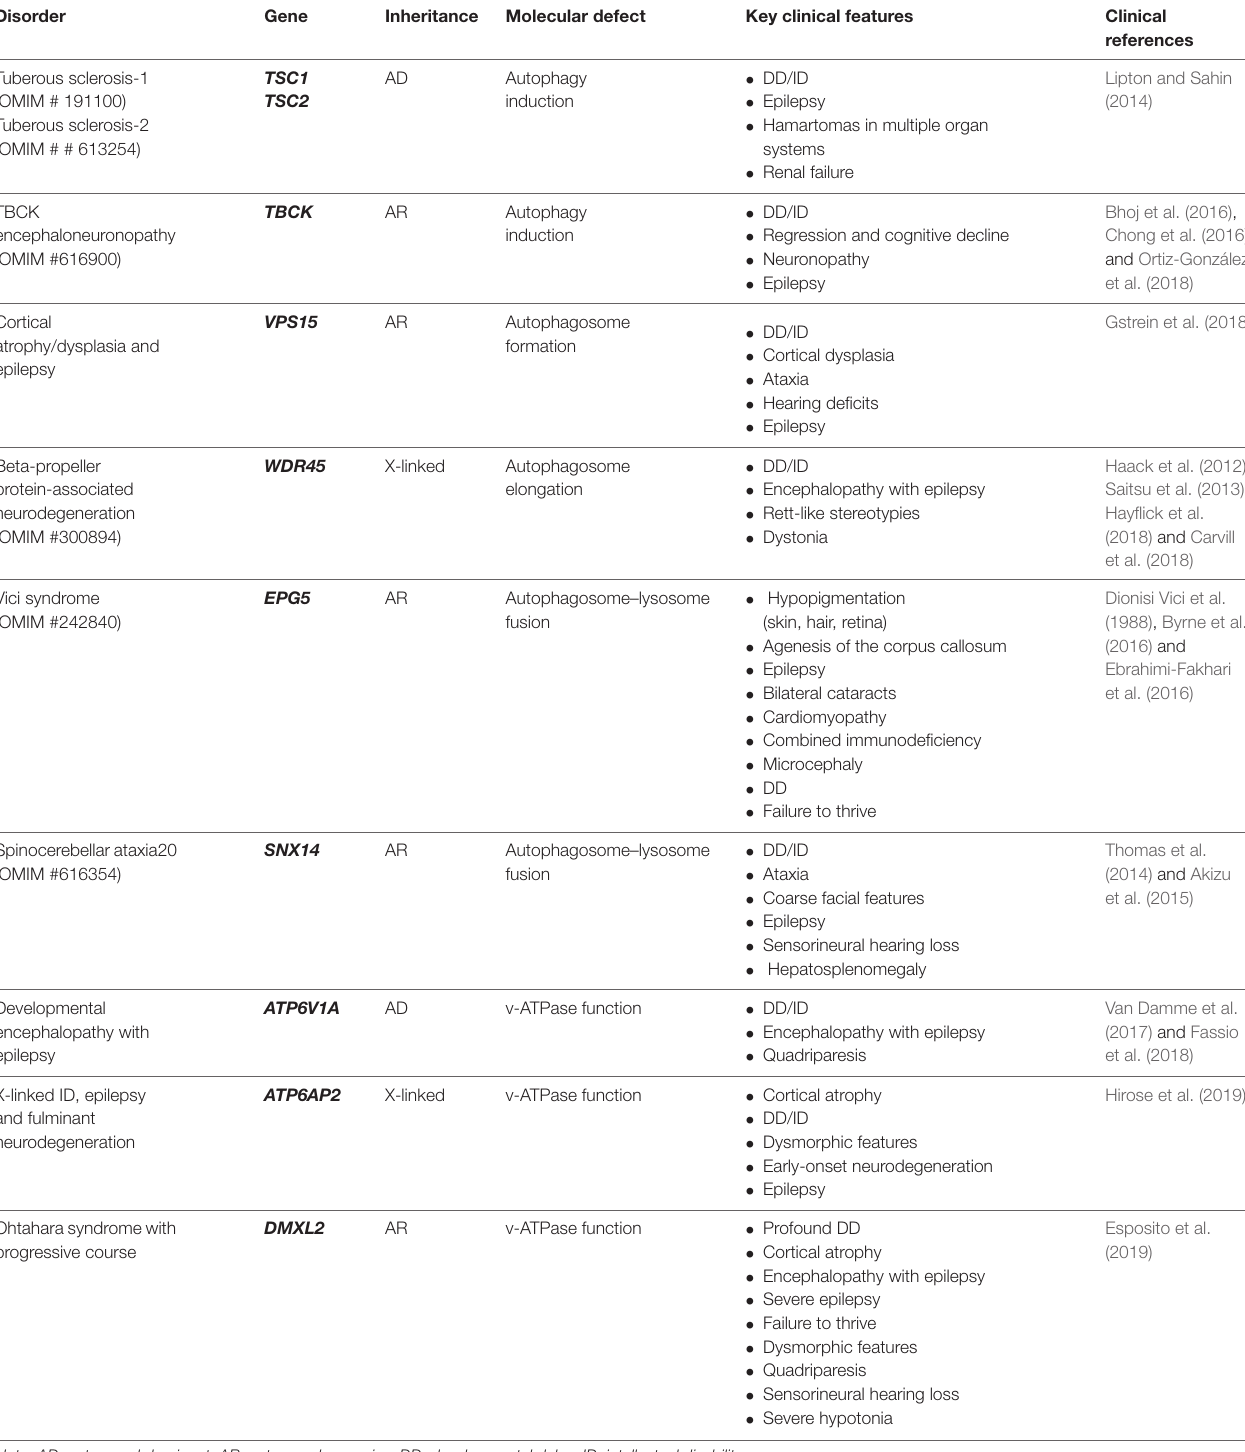
TABLE 1 | List autophagy/lysosomal genes involved in neurodevelopmental disorders with